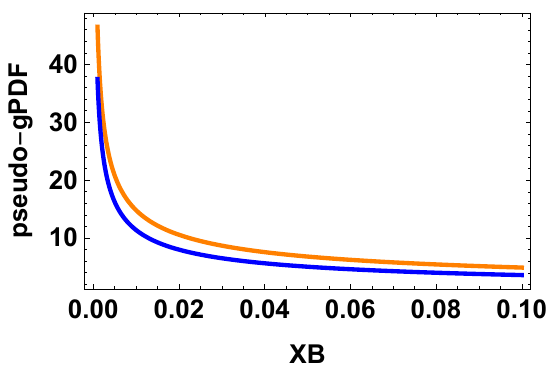
Figure 8 . The orange curve is the numerical integration of the real part of (7.2), while the blue one is the saddle-point approximation (7.3)(real